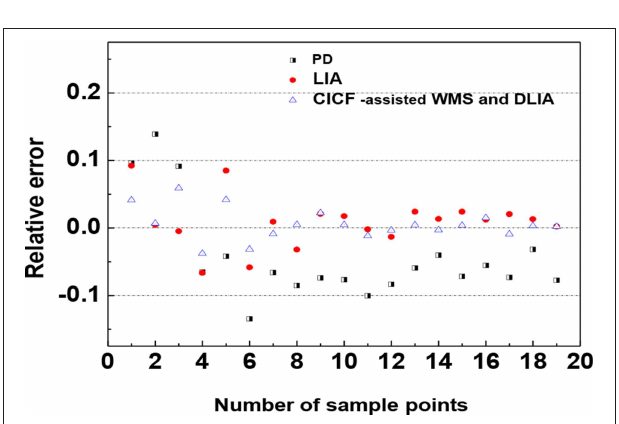
FIGURE 9 | The comparison of the relative errors of the CO 2 concentration measured by the three methods (PD, LIA, CICF-assisted WMS, and DLIA).